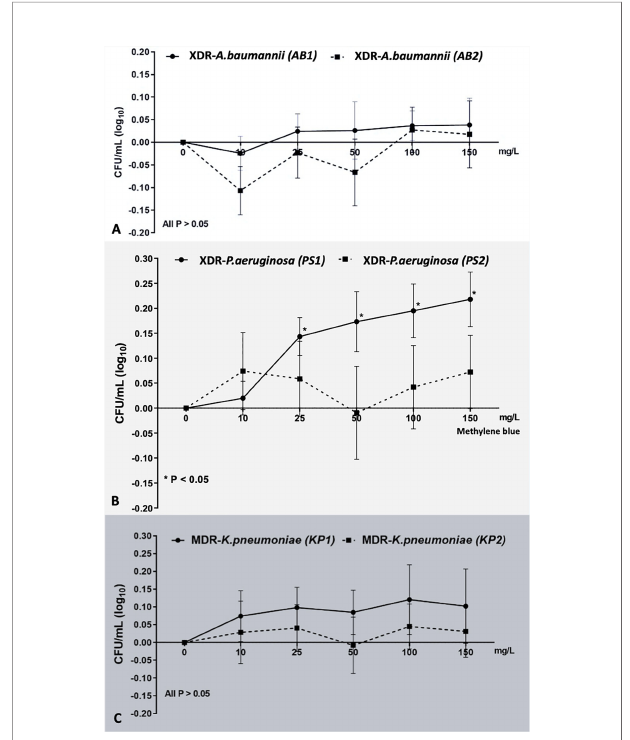
FIGURE 1 | The effect of various MB concentrations on each bacterial strain. MB concentrations could not exhibit the sublethal and lethal effect to all bacterial strains: (A) XDR - AB1 and AB2, (B) XDR - PS1 and PS2, and (C) MDR-KP1 and KP2. *Statistically signi fi cant difference (p-value